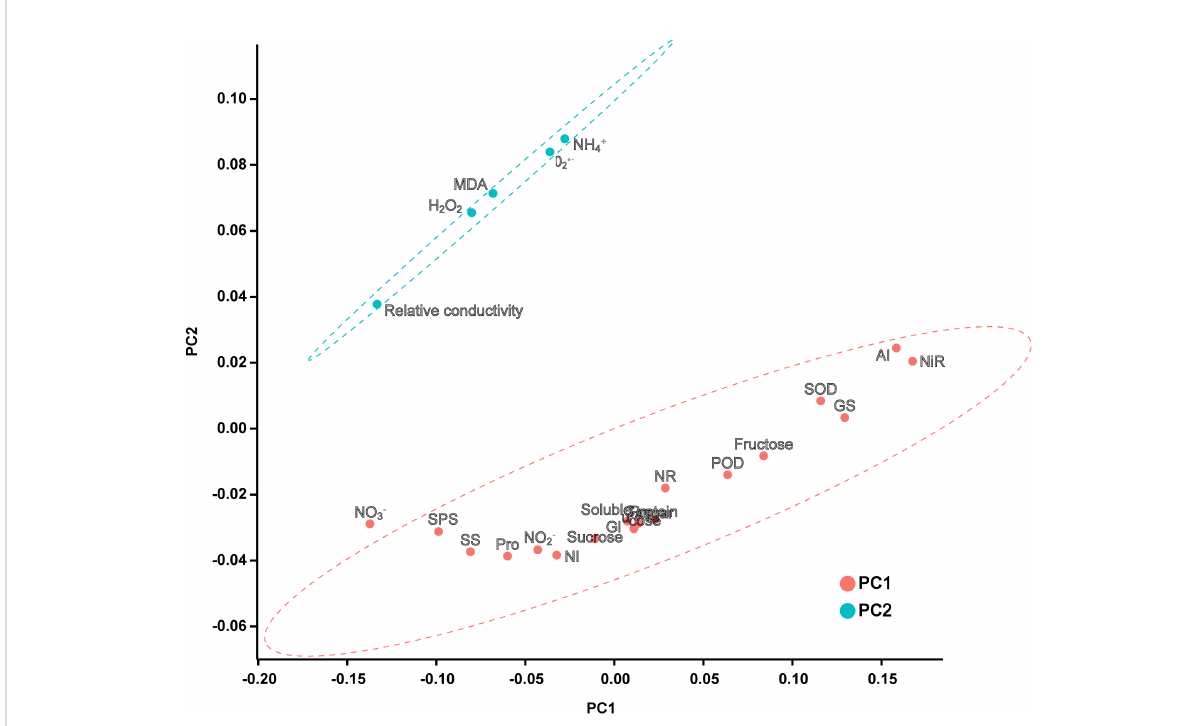
FIGURE 7 PCA score plot of each indicator. According to the principle that the eigenvalue is greater than 1, two principal components are extracted with a con fi dence interval of